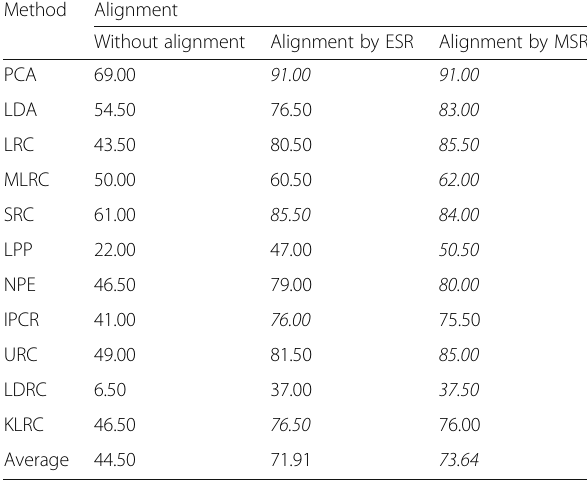
Table 9 Recognition rates on FRGC with different face recognition algorithms (synthesized faces) Method